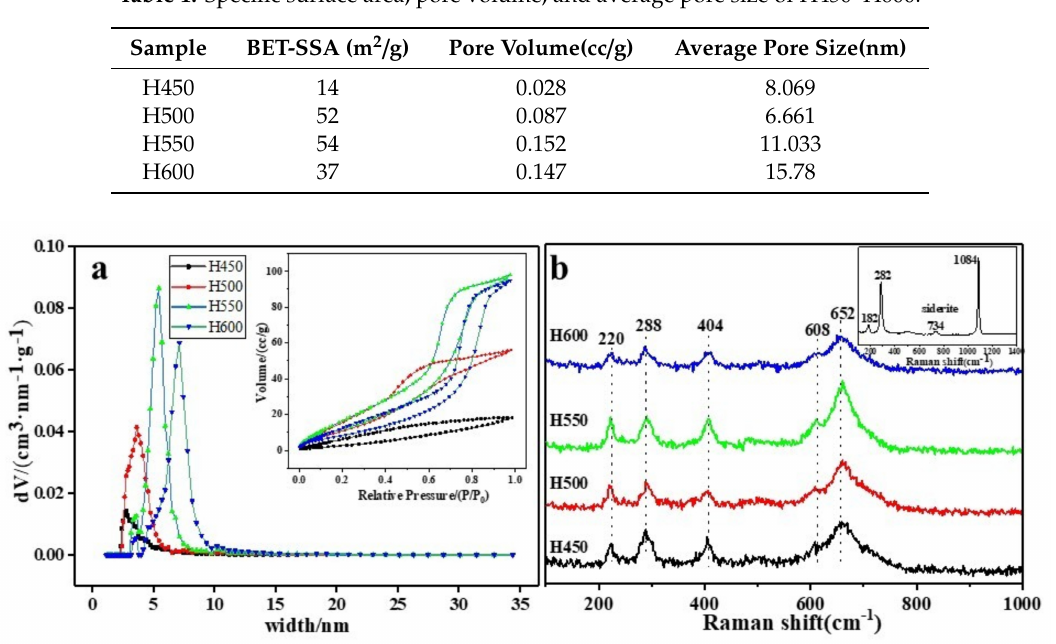
Figure 5. N 2 adsorption-desorption isotherms and pore size distributions ( a ) and Raman spectra ( b ) of the di ff erent